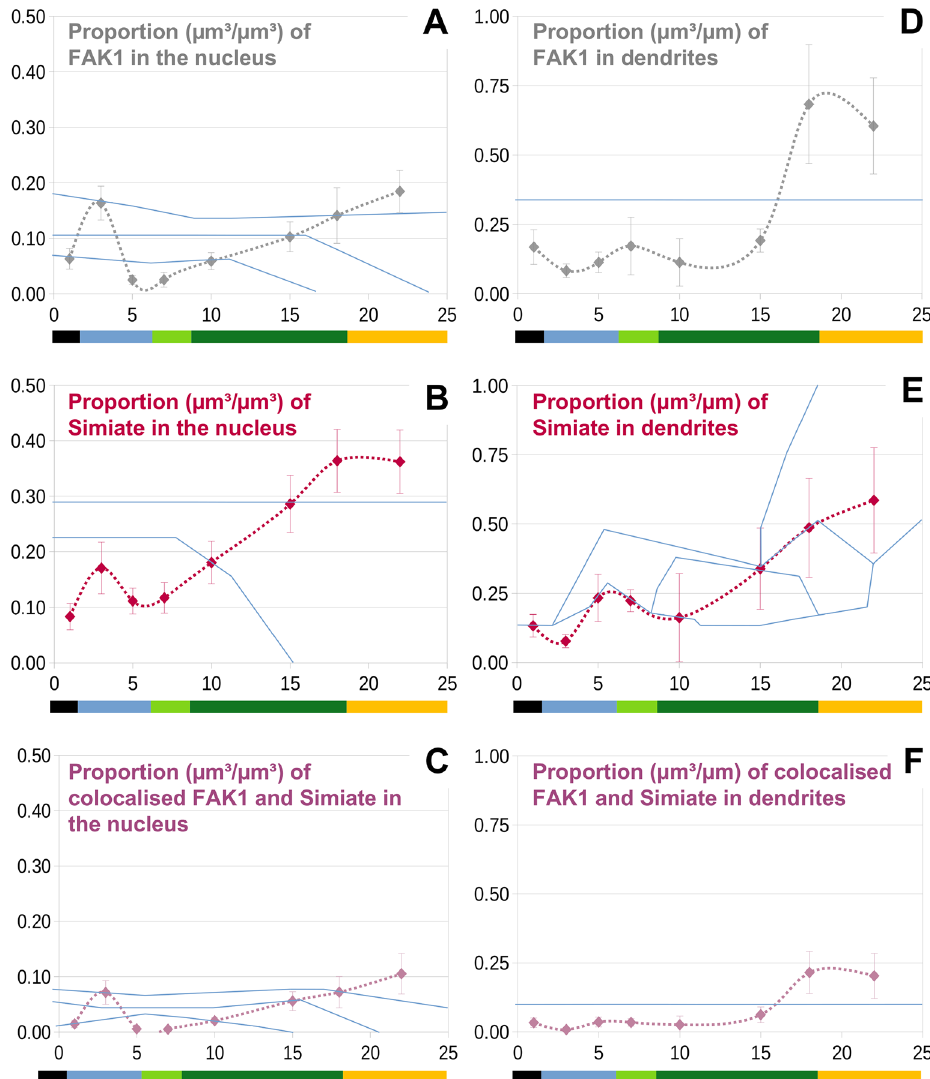
Figure 4. In both, nuclei and dendrites, the proportion of FAK1 and Simiate as well as of their proteins colocalised changes significantly during development. ( A – F ) At several developmental stages between div 1 and div 22, primary hippocampal neurons were analysed for the proportions of FAK1, Simiate and their proteins colocalised in nuclei ( A – C ; µm 3 /µm 3 ) as well as in dendrites ( D – F ; µm 3 /µm). The results show significant changes in the proportions of FAK1 and Simiate during development, thus illustrating that levels of FAK1 and Simiate are regulated independently from cellular growth (cp. Fig. 3). For the different units in the measurements of nuclei (per volume: µm 3 ) and dendrites (per length: µm) numbers do not compare directly though (please also see Fig. 2A/B). In all graphs, blue lines indicate significance borders. Two mean values are significantly different if they are completely separated by at least one blue line, n equals 8–12 in all experiments. Coloured bars indicate the approximate dendritic stage. Black: protrusions indifferent. Blue: axon growth. Green: onset of dendritogenesis and dendritogenesis. Yellow: slowing of